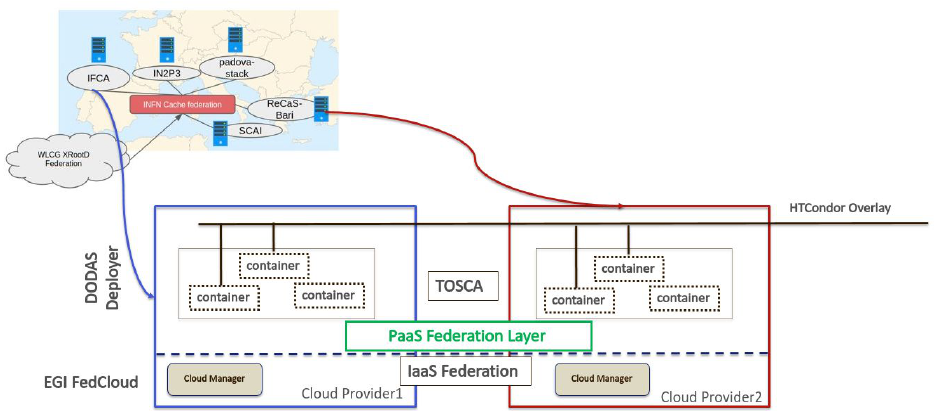
Fig. 2. The figure shows the topology of the 4 sites used in the testbed. Below the schema represents how DODAS integrates with Egi FedCloud. Finally the overlay HTCondor on top of the DODAS deployed sites is